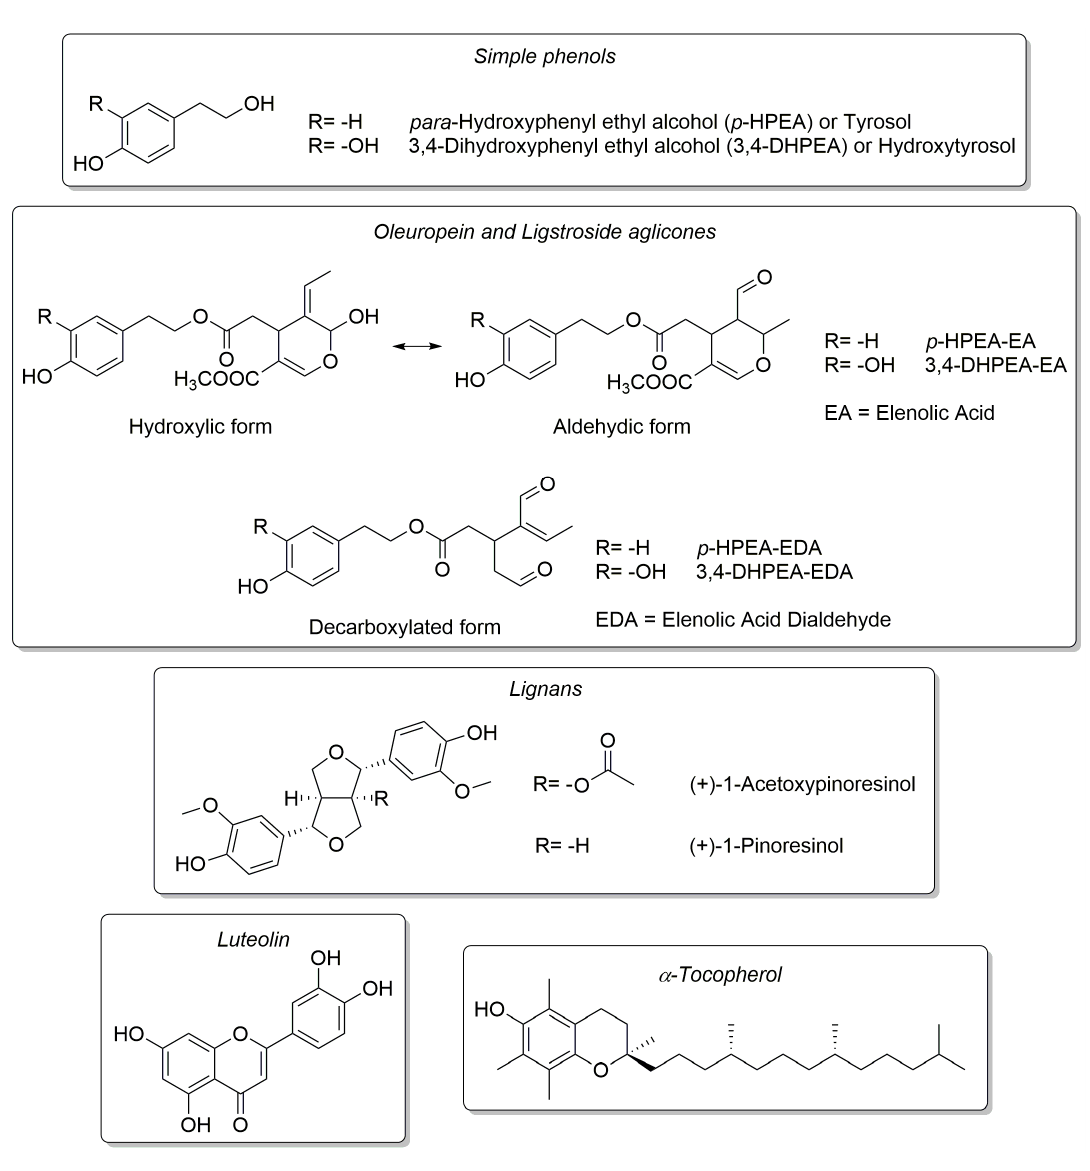
Figure 1. Chemical structures of the antioxidant molecules studied.